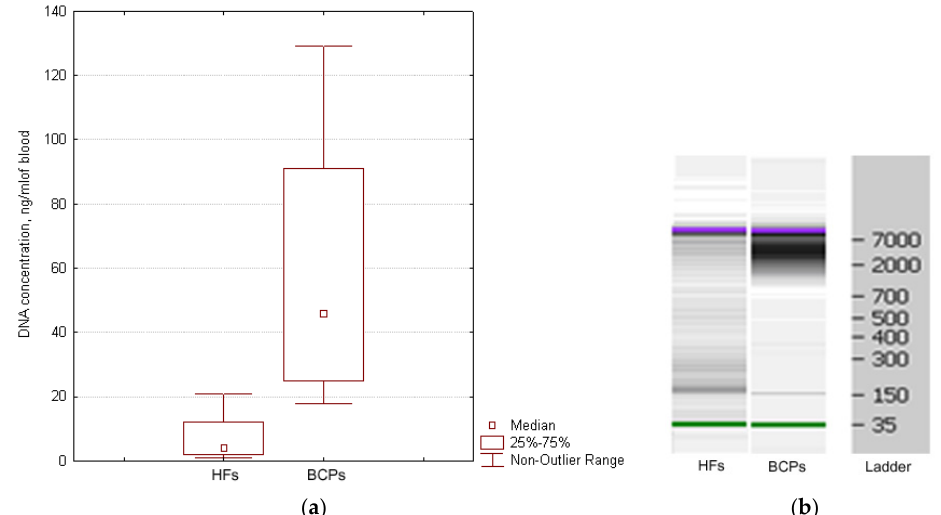
Figure 3. Characterization of cirDNA from the plasma of HFs and BCPs. ( a ) DNA quantification from the plasma of HFs and BCPs. Tukey box plots of cirDNA. Median cirDNA concentration with 25–75% and non-outlier range bars are indicated. ( b ) Size distribution of cirDNA extracted blood plasma of HFs and BCPs. The data from Agilent 2100 Bioanalyzer TM with 35 nt and 10380 nt DNA fragments as an internal standards are shown.